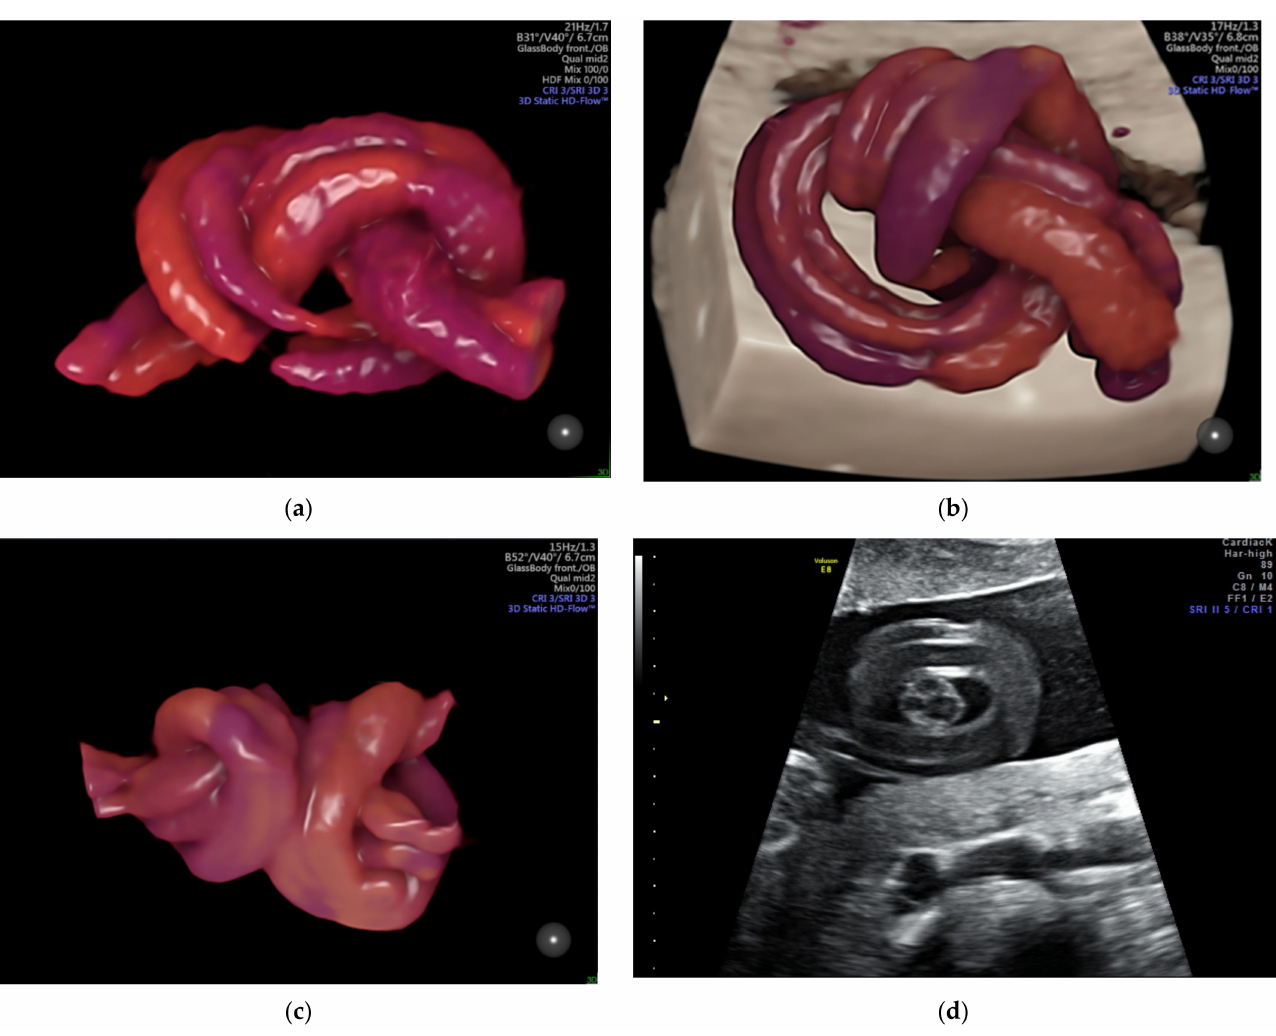
Figure 8. Images of true umbilical knots as ( a – c ) 3D Static HD Flow imaging and ( d ) 2D ultra- sound